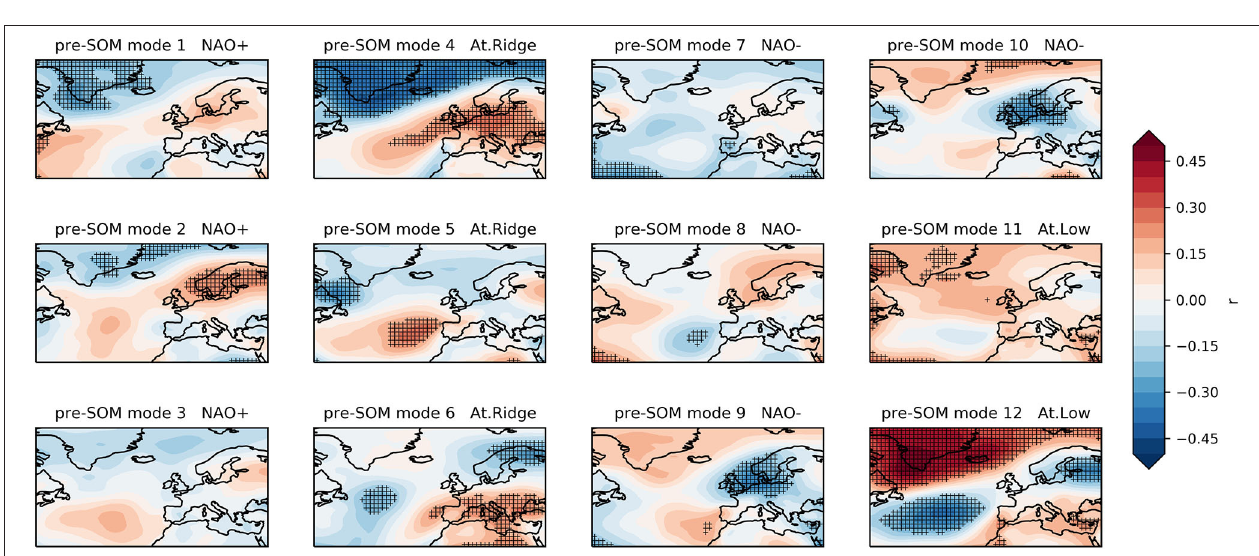
FIGURE 5 | Summer sea level pressure (JA SLP) point-wise correlated to timeseries associated with April SST predictor patterns for the reanalysis over the period 1902–2008. Stippling represents correlation significant at the 95%